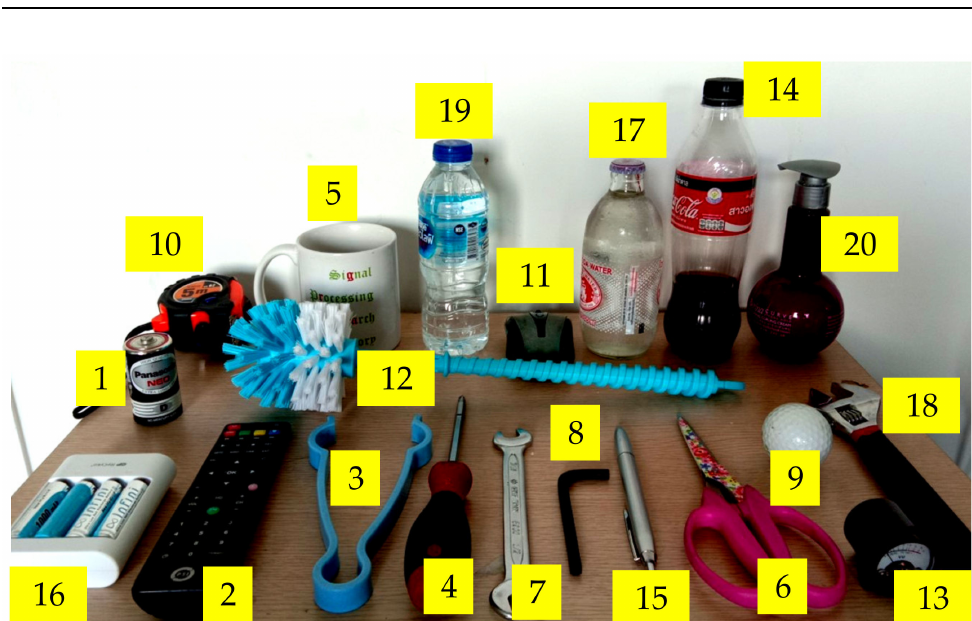
Figure 12. Objects used for model training. (1) battery, (2) remote controller, (3) plastic tongs, (4) screwdriver, (5) coffee cup, (6) scissors, (7) fixed wrench, (8) Alan key, (9) golf ball, (10) measuring tape, (11) computer mouse, (12) brush, (13) amp meter, (14) cola bottle, (15) pen, (16) charger, (17) soda bottle, (18) variable wrench, (19) water bottle, (20) cream